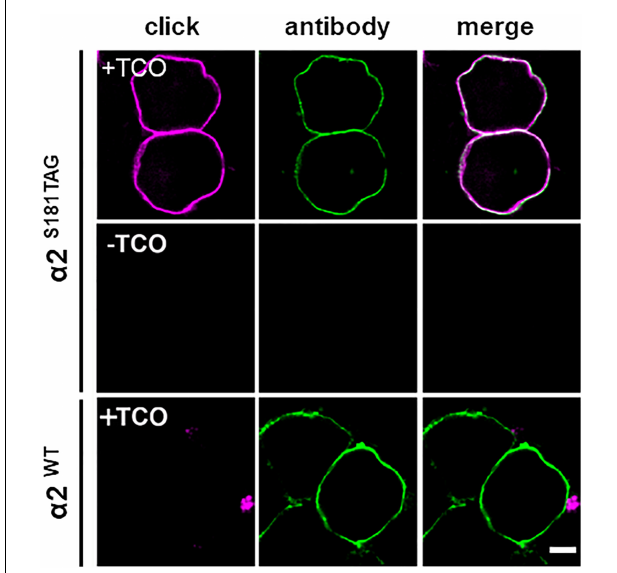
FIGURE 2 | Specificity of bioorthogonal labeling of α 2 click-mutant S181TAG of GABA-A receptor α 2 subunits. Confocal microscopy of membrane-targeted GABA-A receptor α 2 subunits in HEK-293-T cells with coexpression of β 1 and γ 2 subunits to ensure bonafide membrane delivery of receptors. The ncAA TCO* was click-labeled with the tetrazine-dye H-tet-Cy5 (magenta). Antibody labeling of HA-tag (green) serves as positive control for GCE as the HA tag is located at the n-terminal part of the protein and expression of HA-tag is only feasible after successful ncAA incorporation. The lower panels show negative controls with omission of ncAA feeding (-TCO) after transfection of the S181TAG mutant and low unspecific background signal of H-tet-Cy5 (magenta) on WT α 2 receptors (green) supplied with ncAA (+TCO). Scale bar, 5 µ m.